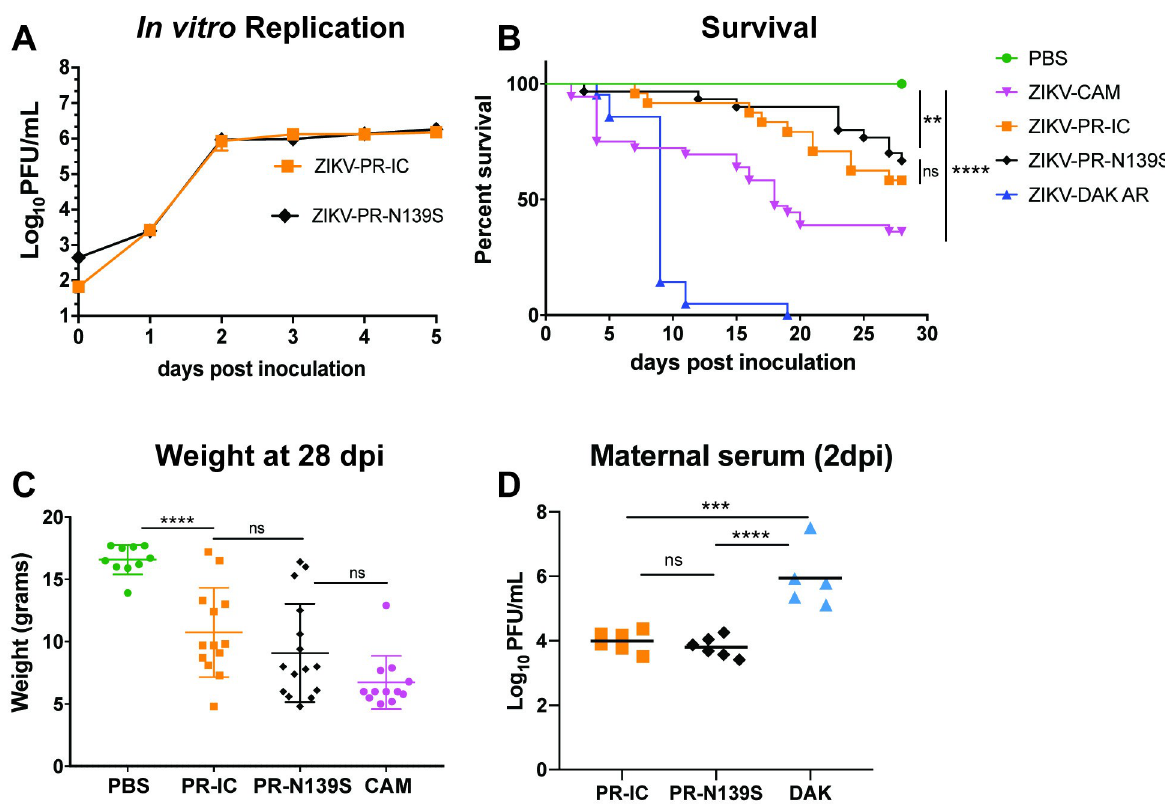
Fig 1. In vitro and in vivo characterization of ZIKV strains. (a) In vitro growth kinetics of ZIKV-PR-IC and mutant ZIKV-PR-N139S on Vero cells. Data points represent means of three replicates at each time point ± standard deviation. Cells were inoculated at an MOI of 0.01 PFU/cell. Titer was measured (PFU/ml) by plaque assay. Growth curves were not significantly different. (b) Survival curves of neonatal BALB/c mice intracranially inoculated with 10 PFU of different strains of ZIKV. PBS: n = 18; ZIKV-CAM: n = 36; ZIKV-PR-IC: n = 24; ZIKV-PR-N139S: n = 30; ZIKV-DAK: n = 20. All strains caused significant mortality by 28 dpi when compared to PBS (Fisher’s exact test). As compared to PBS controls: ���� p < 0.001; �� p < 0.002; ns, not significant. (c) Weight in grams of surviving intracranially inoculated pups at 28 days post infection. ���� p < 0.0001; ns, not significant (student’s t-test). (d) Time-mated Ifnar1-/- dams were inoculated with 10 3 PFU of ZIKV on E7.5 and maternal infection was confirmed by plaque assay on day 2 post inoculation. ��� p < 0.002; ���� p < 0.0001; ns, not significant (one-way